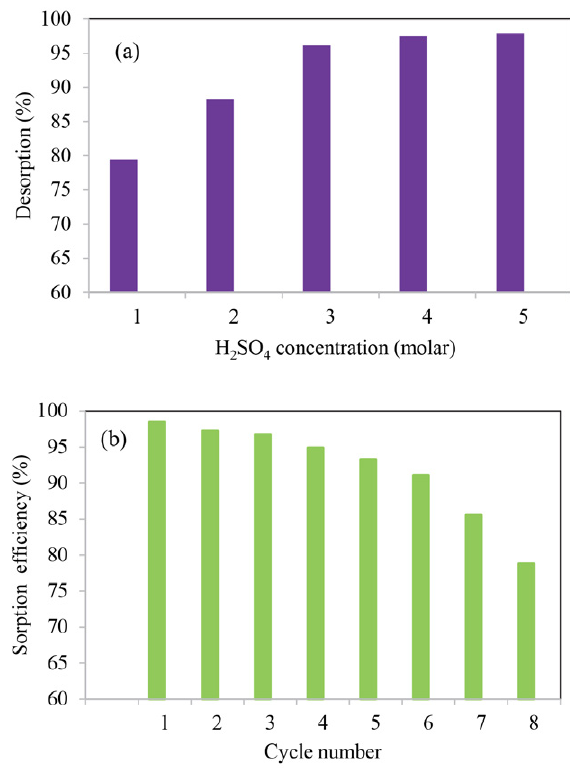
Figure 13. Desorption efficiency (a) and reusability (b) of MnFe 2 O 4 nanoparticles for removal of P ions from aqueous